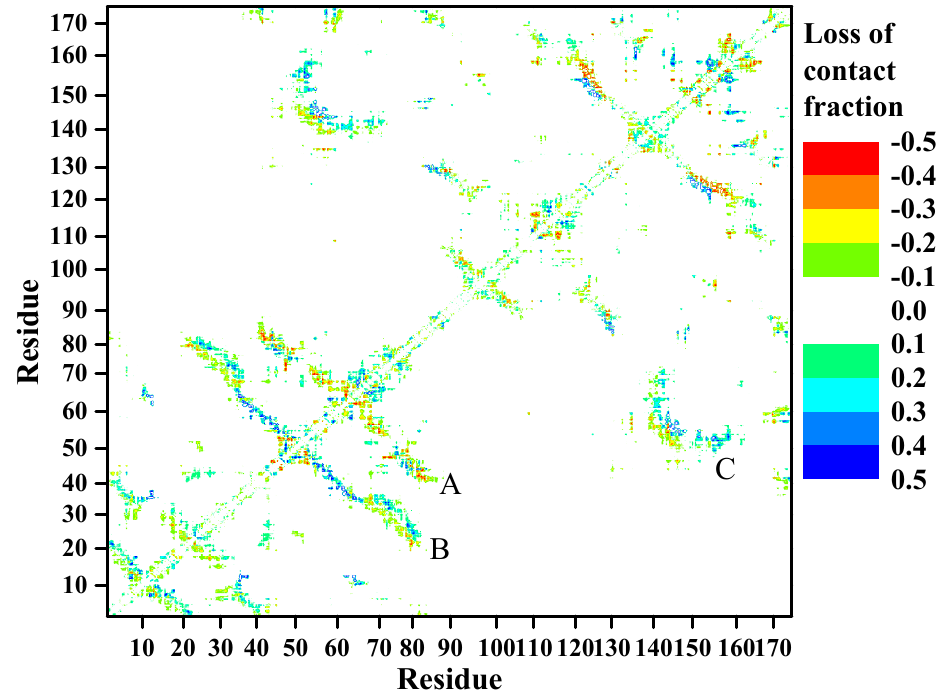
Figure 5. Subtractive 2D residue contact map of the denaturant-induced HGDC structures in phys- iological solution, 425 K, over 100 ns of simulation time. Negative loss of contact (redder hue) denotes greater loss in the urea-induced structure, positive loss (bluer hue) denotes greater loss in the GdnHCl-induced structure. Region A represents contacts between residue regions D65~M70 (motif 2 loop between β 3- and β 4-strands) and Q55~A64 (motif 2 β 2- and β 3-strands), G71~H84 (motif 2 β 4-strand) and S40~N50 (motif 2 β 1-strand). Region B represents contacts between regions P49~P83 (motif 2 β 2-, β 3-, and β 4-strands) and H23~N50 (motif 1 β 3-strand and motif 2 β 1-strand). Region C represents contacts between N138~A162 (motif 4 β 2- and β 3 strands) and N50~L72 (motif 2 β 2- and β